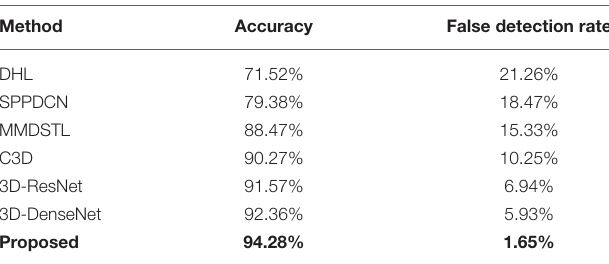
TABLE 3 | Comparison with different methods on KTH data.